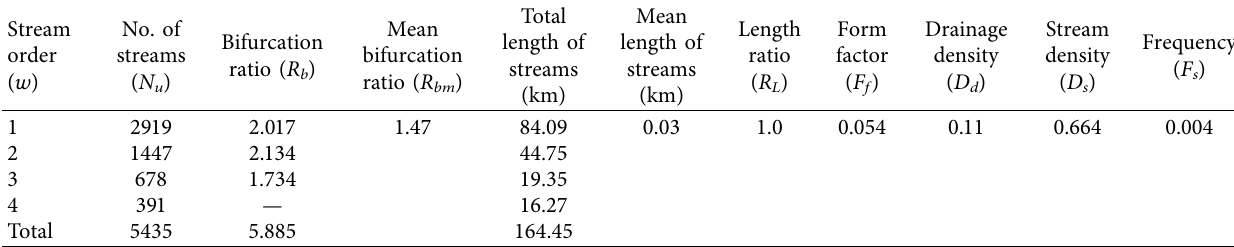
Table 3: Aspects of Kannad taluka’s watershed that are linear.